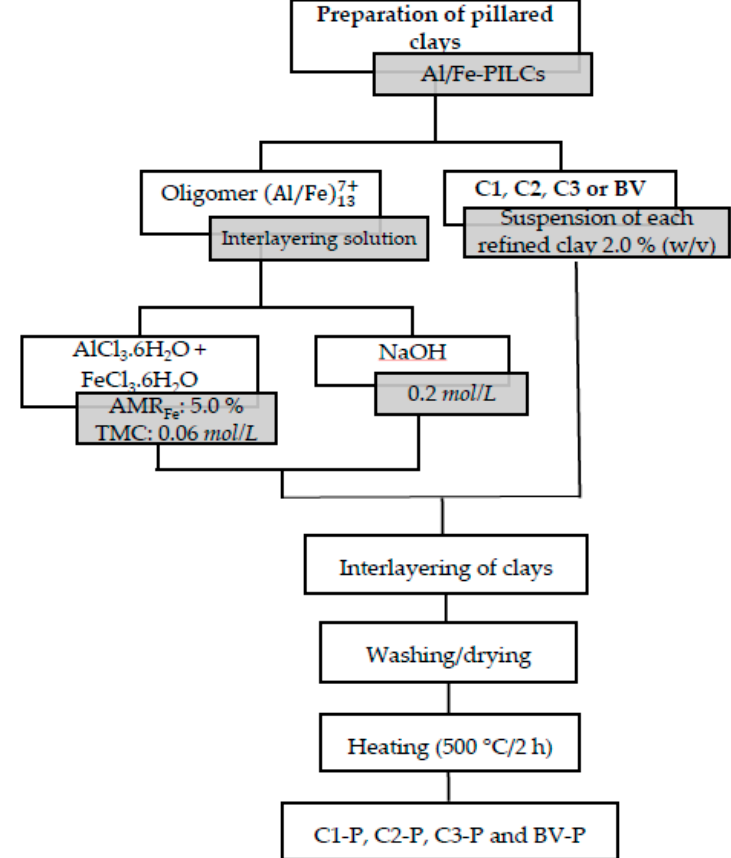
Figure 1. Experimental procedure of the preparation of pillared clays.